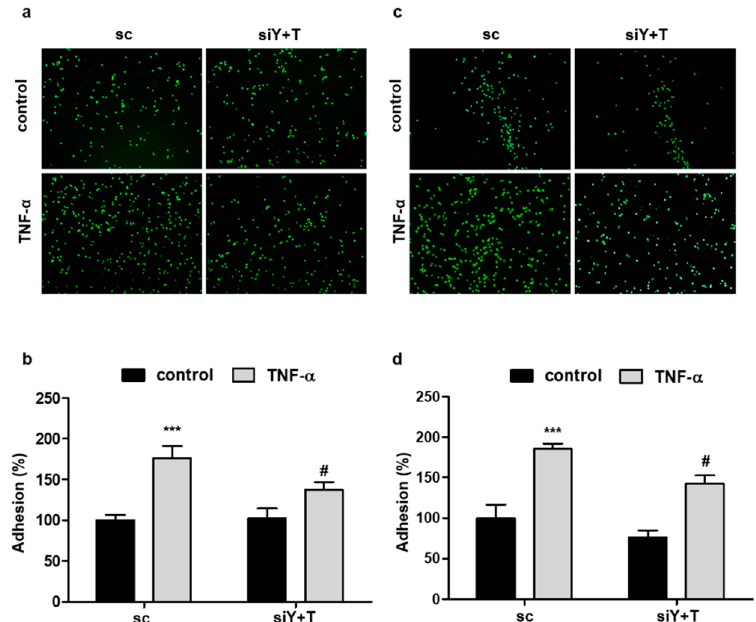
Figure 4. Knockdown of YAP/TAZ inhibits TNF- α -induced adhesion of monocytes to endothelial cells. ( a , c ) HUVECs were transfected with scrambled control (sc) or YAP/TAZ (Y+T) siRNA for 24 h. Monolayer endothelial cells were treated with TNF- α (20 ng/mL) for 4 h and co-cultured with calcein AM-labeled THP-1 ( a ) or U937 ( c ) cells for 1 h. Representative images are shown. ( b , d ) The fluorescence intensities of attached THP-1 ( b ) or U937 ( d ) cells were quantified with a fluorometer. Data are presented as the mean ± S.E. ( n = 3 independent experiments). *** p < 0.001 vs. untreated scrambled siRNA-transfected cells and # p < 0.05 vs. TNF- α -treated scrambled siRNA-transfected cells.